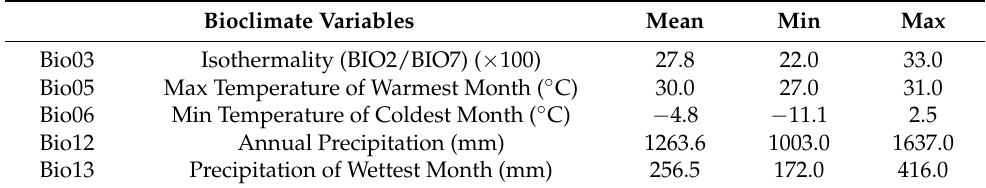
Table 1. Bioclimatic variables on the distribution of Lithobates catesbeianus in South